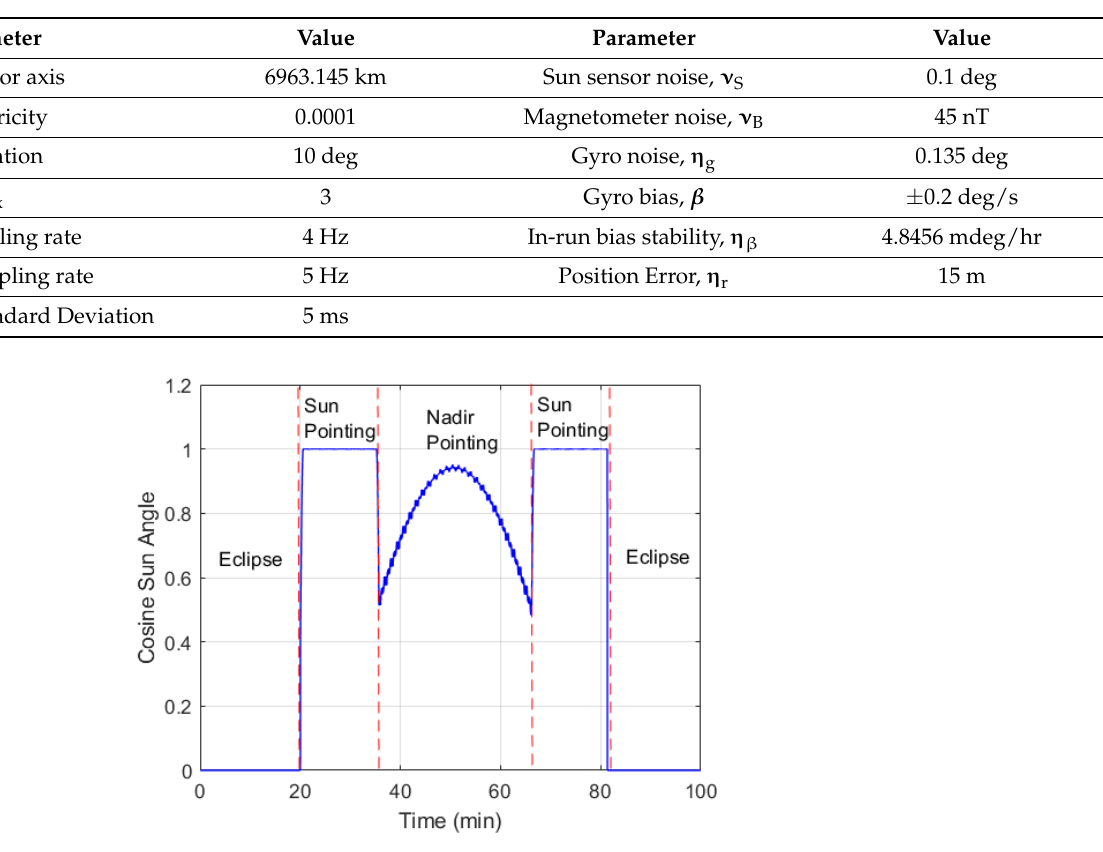
Figure 5. Satellite attitude control condition for Monte Carlo simulation.